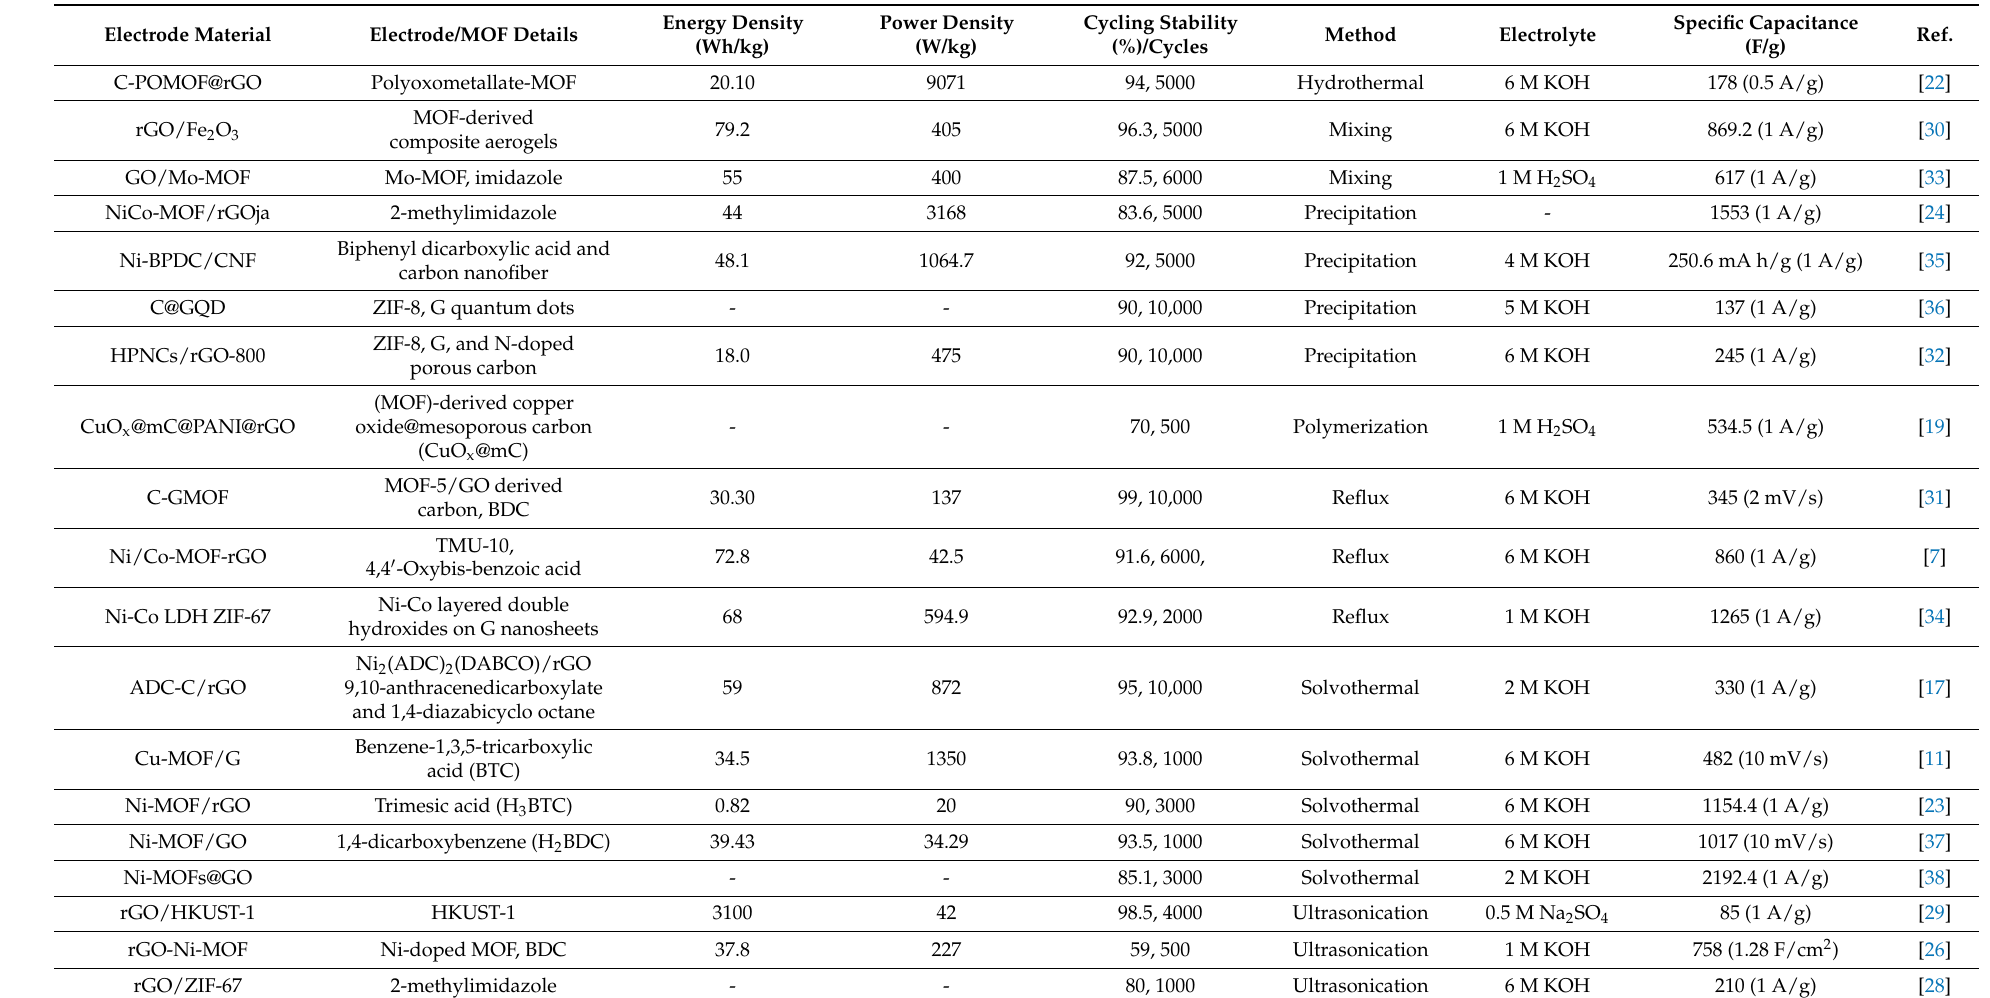
Table 1. Comparison of electrochemical performances for MOF/G-based